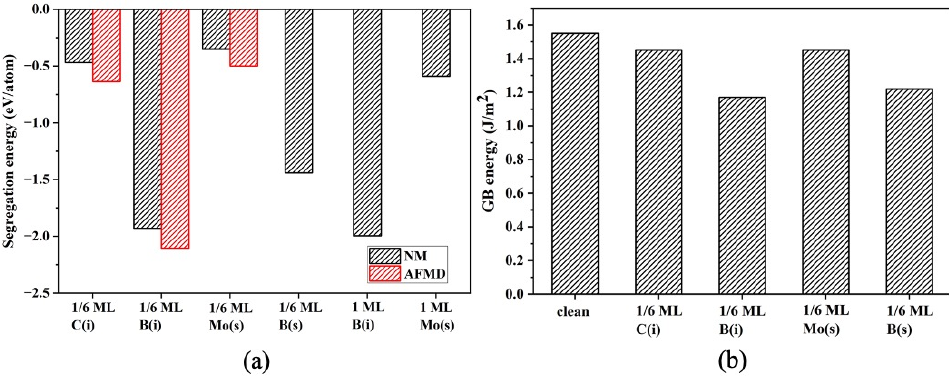
Figure 2. Segregation energy ( a ) and GB energy ( b ) of different systems. Figure 3 compiles the X 1 –X 2 and Mo–X interaction energy at dilute limit. The interac- tion energy between interstitials is rather weak, oscillating within ±0.04 eV. The calculated results indicate an attractive interaction between Mo and B/C atoms beyond an intera- with Mo and with themselves at the GB. When the concentration of Mo and interstitial B − 1.82 eV. The strong attractive interaction indicates the co-segregation of Mo and B at the austenite GB, consistent with experimental observation by atom probe tomography [32]. Figure 3. Interaction energy between interstitial solute atoms ( a ) and between Mo and interstitials ( b ). The partitioning energies for B and Mo are plotted in Figure 4. The energy required for an interstitial B atom to partition from clean GB to Fe 23 C 6 precipitate is 0.18 eV. The positive sign indicates that interstitial B is reluctant to form borocarbide. When a mono- layer of Mo is present at the GB, the partitioning energy is further increased to 0.21 eV (Figure 4a). By definition, an increase in partitioning energy indicates that the partitioning from the GB into the precipitate becomes more difficult. As interstitial B atoms are strongly attracted by Mo atoms, they prefer to co-segregating with Mo at the GB, rather than entering the precipitate until all the interstitial sites have been occupied.